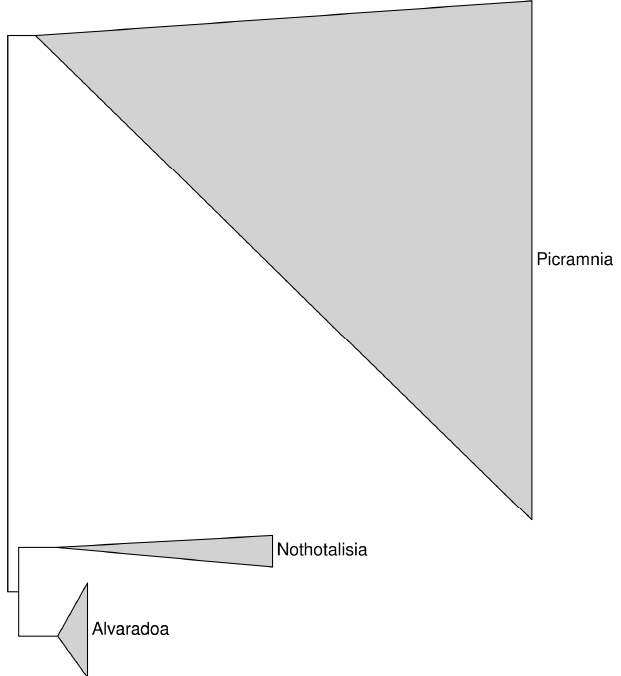
Figure 3. The overview of our phylogeny trees depicting the relationships and relative size of the three strongly supported monophyletic genera of Picramniaceae. Each triangle is the result of concatenation applied to the branches of the phylogenetic